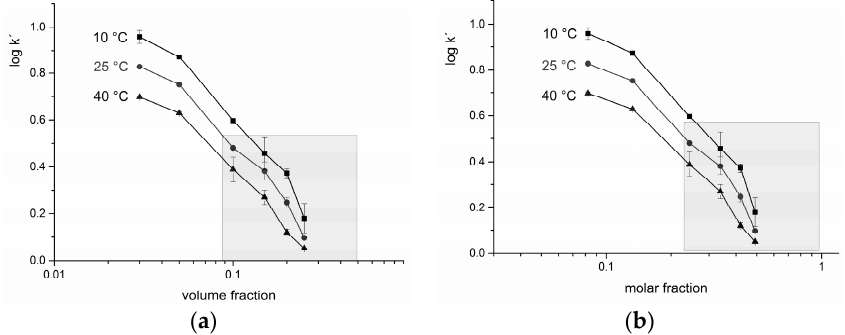
Figure 4. Elucidation of adsorption/partitioning mechanism of HILIC. Dependence of log k ′ on ( a ) volume fraction; and ( b ) molar fraction, respectively, of water in the mobile phase. The shaded area marks a low retention region that is not commonly applied; typical conditions for HILIC are up to 0.1 (volume fraction) or 0.2 (molar fraction) of water, respectively. Error bars show the standard deviations of at least three replicates.